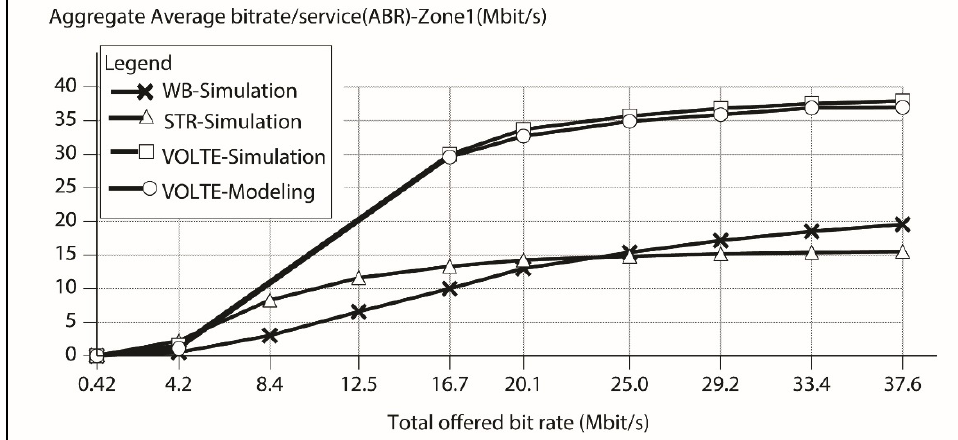
Figure 4. Zone 1: aggregate average bit rate.